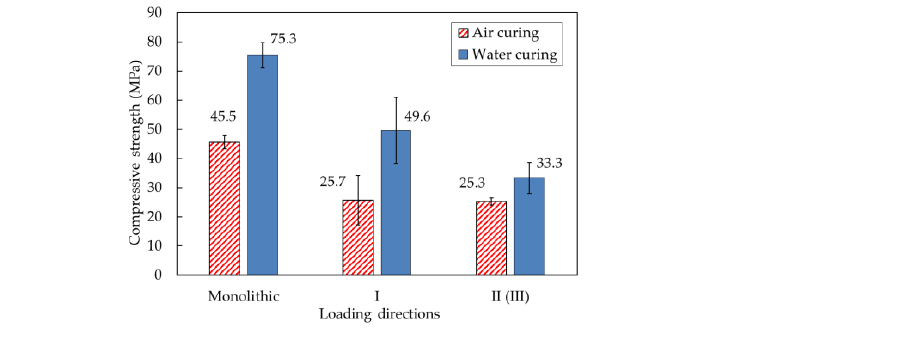
Figure 14. Comparison of the compressive strengths of mortar samples produced with different curing conditions.